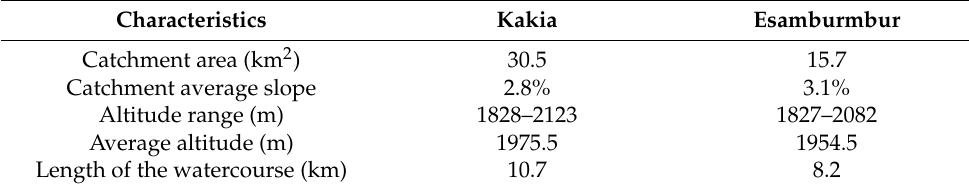
Table 3. Identified characteristics of the study areas.